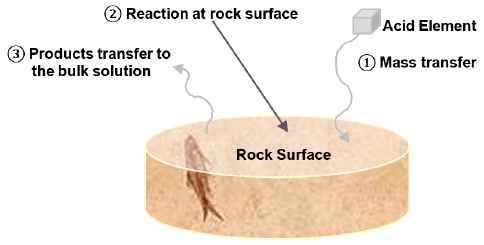
Figure 2. Acid reaction with the rock